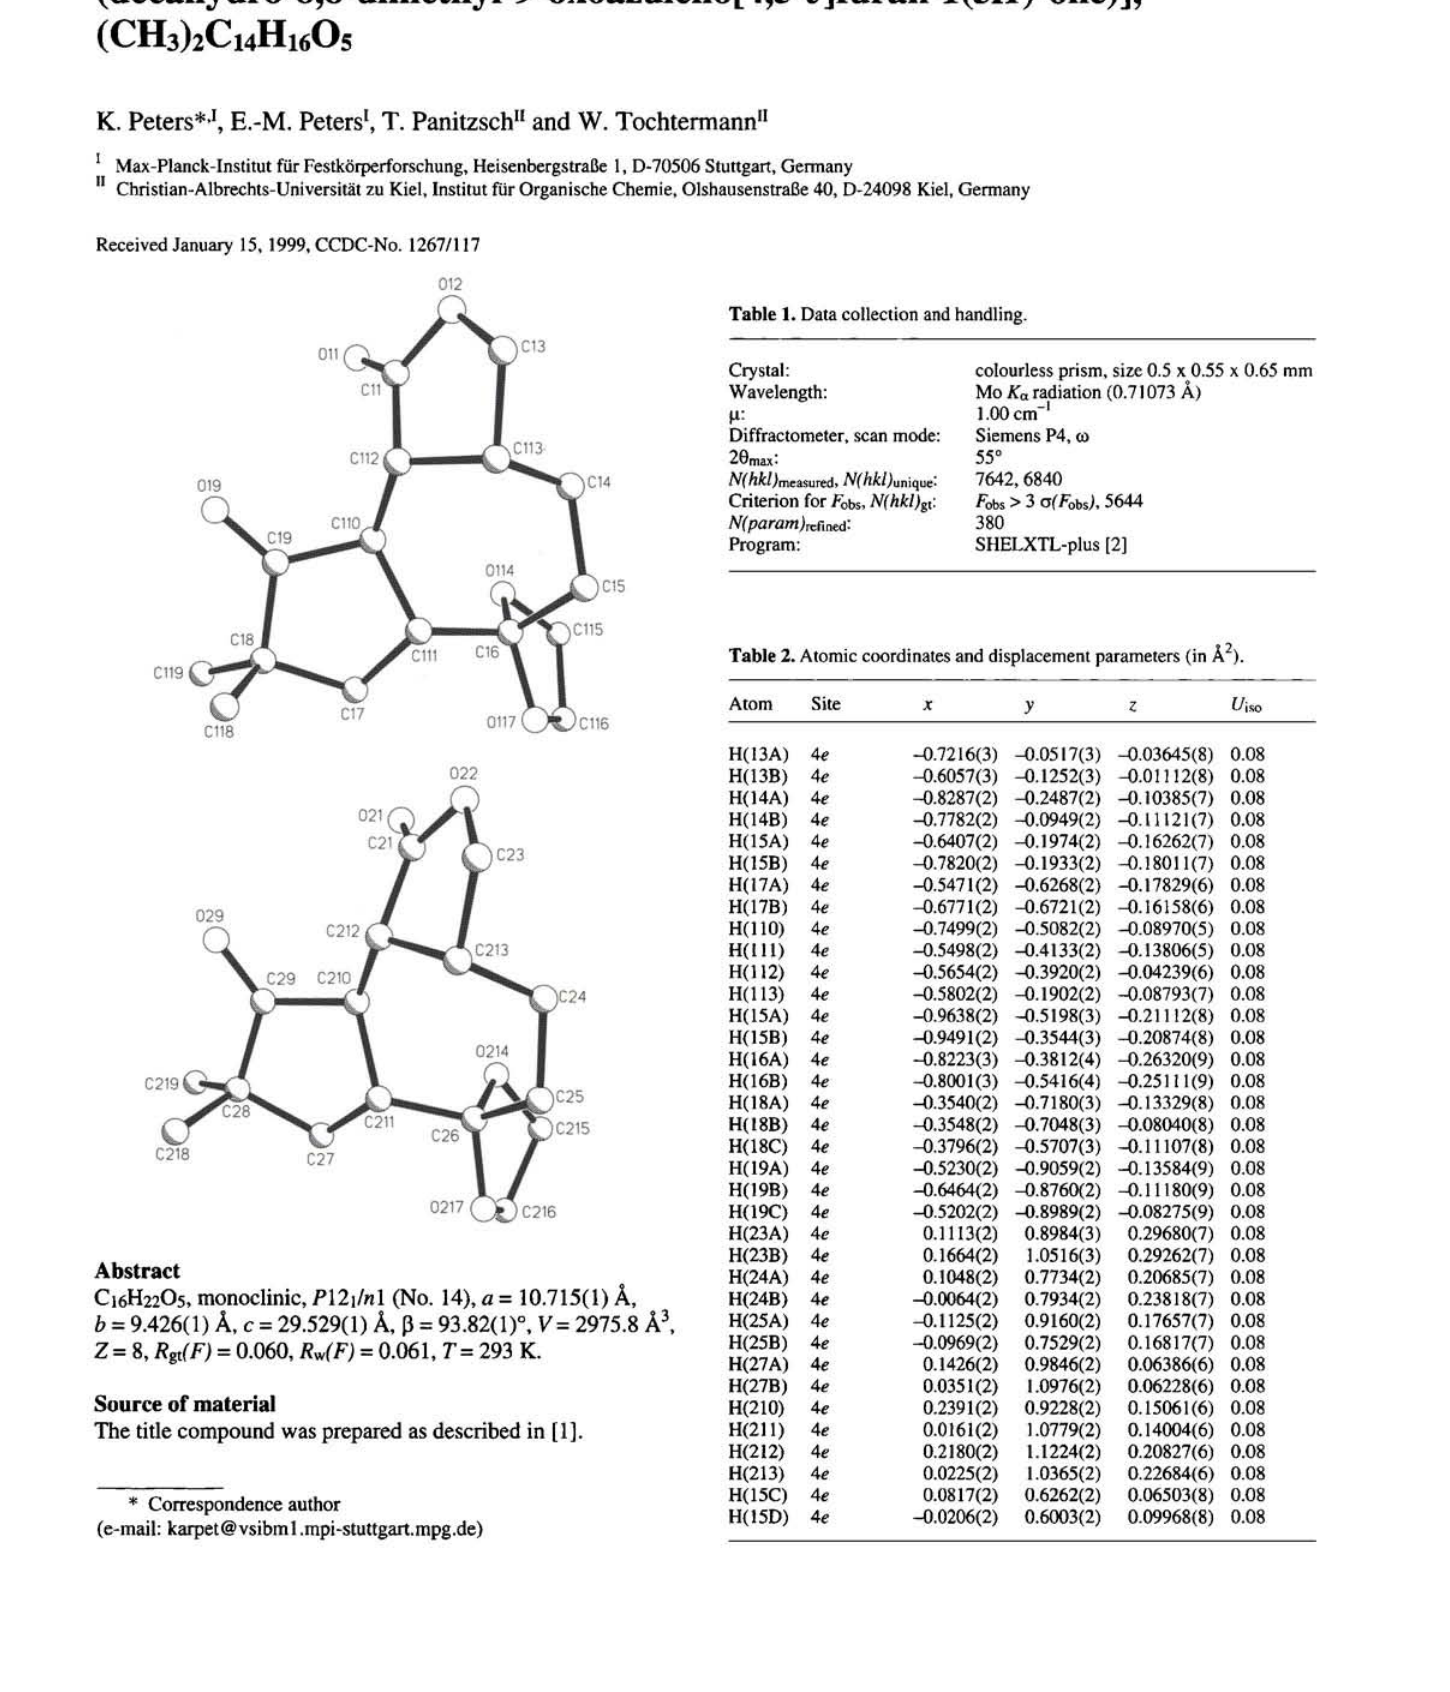
Table 1. Data collection and handling.